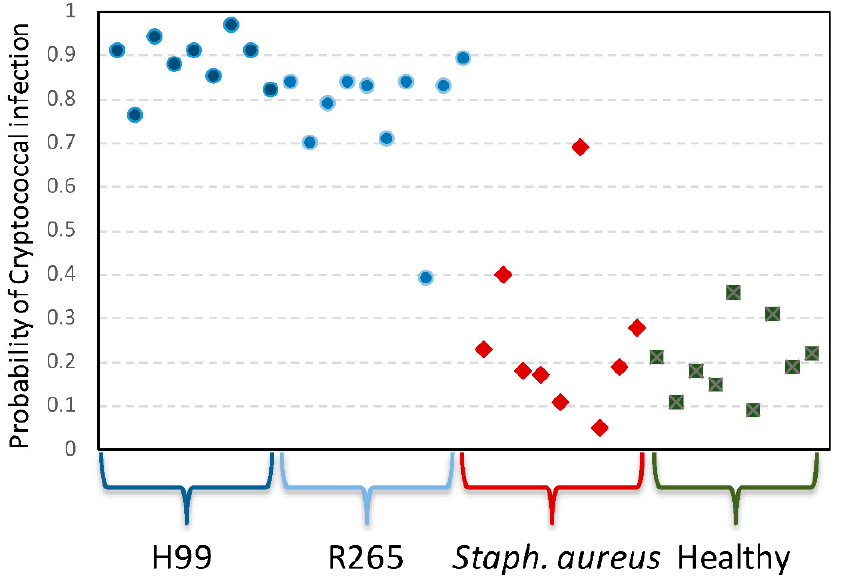
Figure 5. Performance of a 27-gene transcriptomic signature of cryptococcal infection. Depicted are calculated probabilities of cryptococcal infection for individual mice infected with C. neoformans (“H99”), C gattii (“R265”), Staphylococcus aureus , or uninfected control animals (“Healthy”).